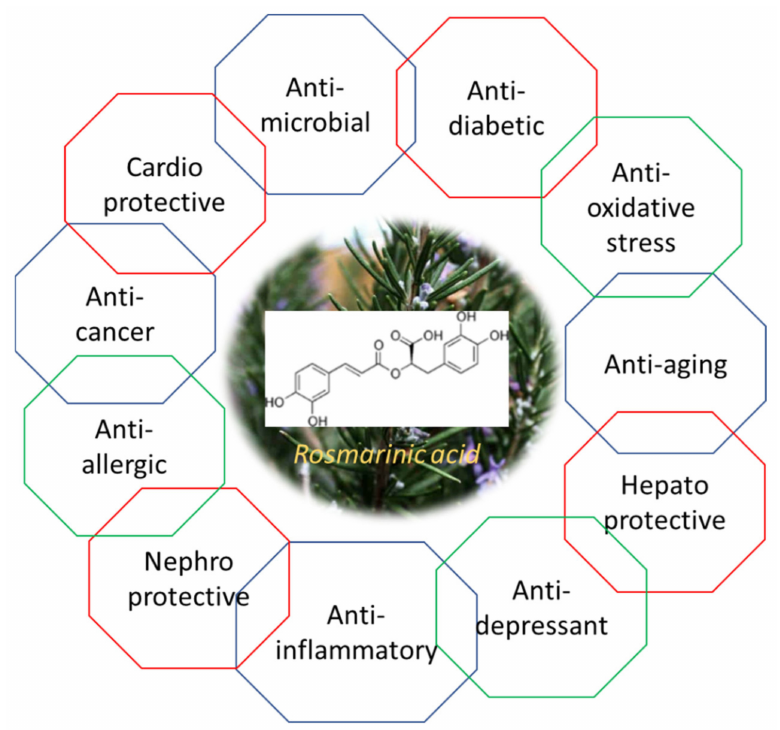
Figure 11. Exploitable properties of